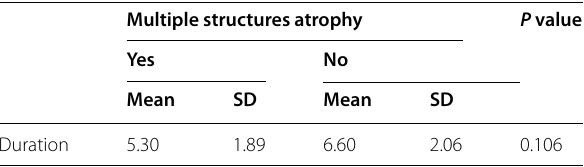
Table 15 Relation between the duration of illness and presence of multiple structure atrophy